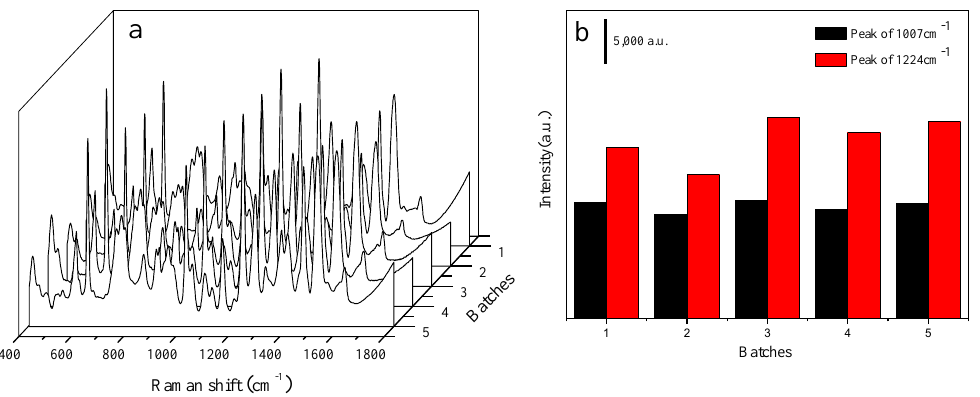
Figure 5. ( a ) SERS spectra of CBZ tested with batches of NCF-Ag-8. ( b ) Bands at 1224 and 1270 cm −1 . The sensitivity of NCF-Ag-8 was further tested by using it to detect CBZ of various concentrations. Figure 6a shows the SERS spectra of different concentrations of carbendazim from 10 − 4 ~10 − 7 M, with all of them presenting clearly resolved peaks. In addition, the peak intensity was plotted against the concentration in the range from 10 − 4 ~10 − 7 M in Figure 6b and showed good linearity with R 2 = 0.98. Moreover, the limit of detection (LOD) for NCF–Ag NPs was determined to be 10 − 8 M CBZ (Figure 6c). SERS spectra of 10 − 8 M exhibited peaks with weak intensities on the basis of the characteristic bands at 1007, 1224, and 1270 cm − 1 . These bands are associated with C–N bending, C–C bending, and C–O–CH 3 stretching, NH AM and NH IZ in plane deformations [16]. According to Aaron [36] and Furini [35], the benzimidazole group interacts with the NCF and Ag surface because of its closer proximity than the aliphatic group and, which is the reason for the intensified bands at 1224 and 1270 cm − 1 . The low LOD indicates the possibility of using NCF-Ag for trace analysis.